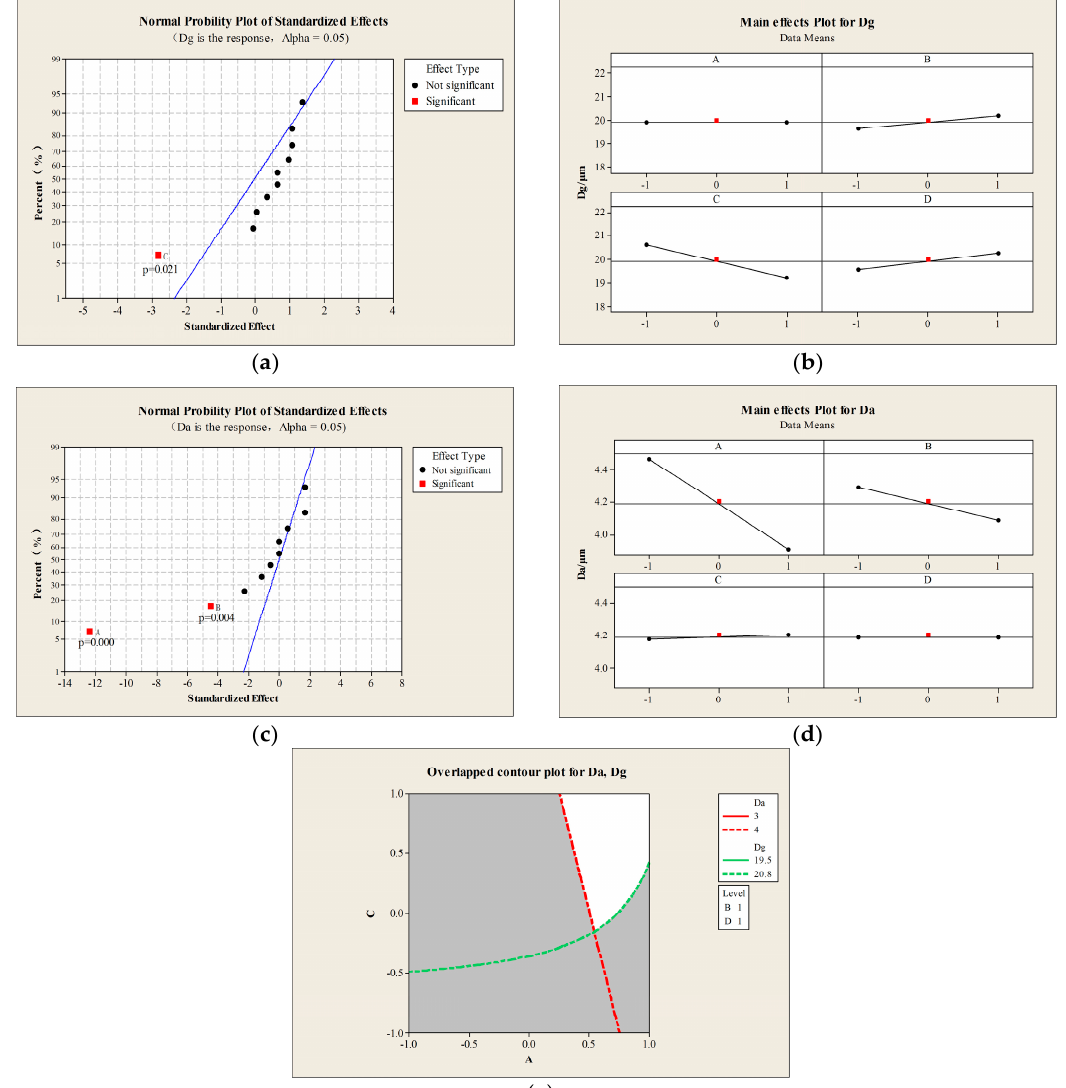
Figure 2. Minitab analysis: ( a ) Standardized effect of factors on Dg; ( b ) main effects plot for Dg; ( c ) standardized effect of factors on Da; ( d ) main effects plot for Da; ( e ) overlapped contour plot for both Da and Dg; (A) menthol: PLLA (w/w); (B) PLLA concentration (wt/v, %); (C) voltage (kV); and (D) push speed (mm/h).